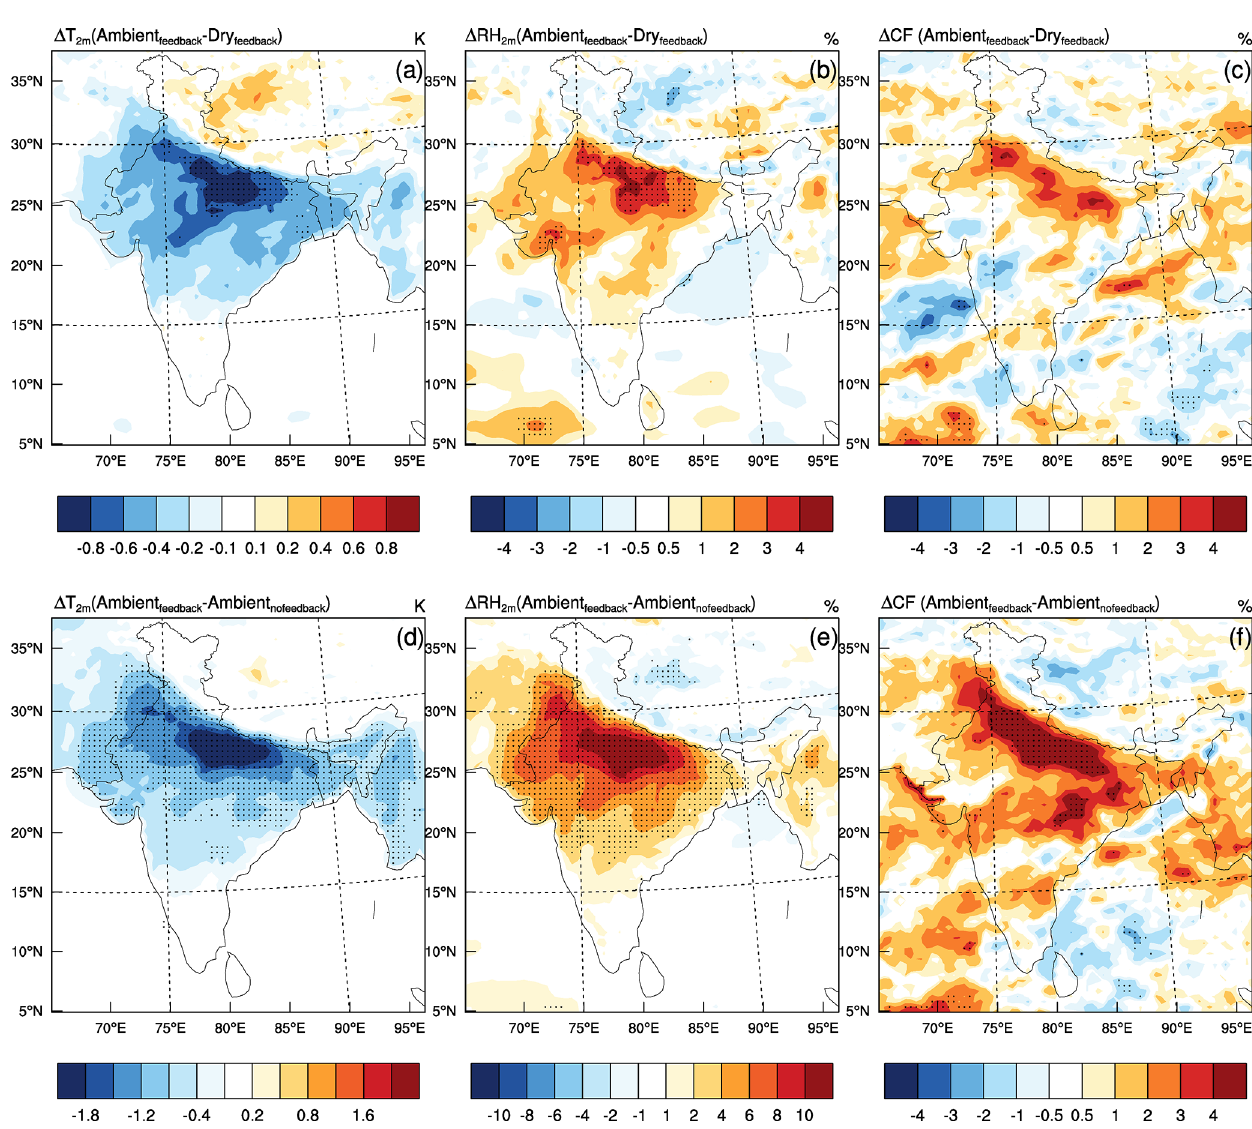
Figure 5. Change in (a) 2m air temperature, (b) relative humidity and (c) cloud fraction solely due to the hygroscopic growth of aerosols (ambient − dry). Change in temperature, relative humidity (RH) and cloud fraction due to the total effect of aerosols (dry + hygroscopic growth) is shown in (d) , (e) and (f) . Dots indicate statistical significance of Student’s t test at a 90%